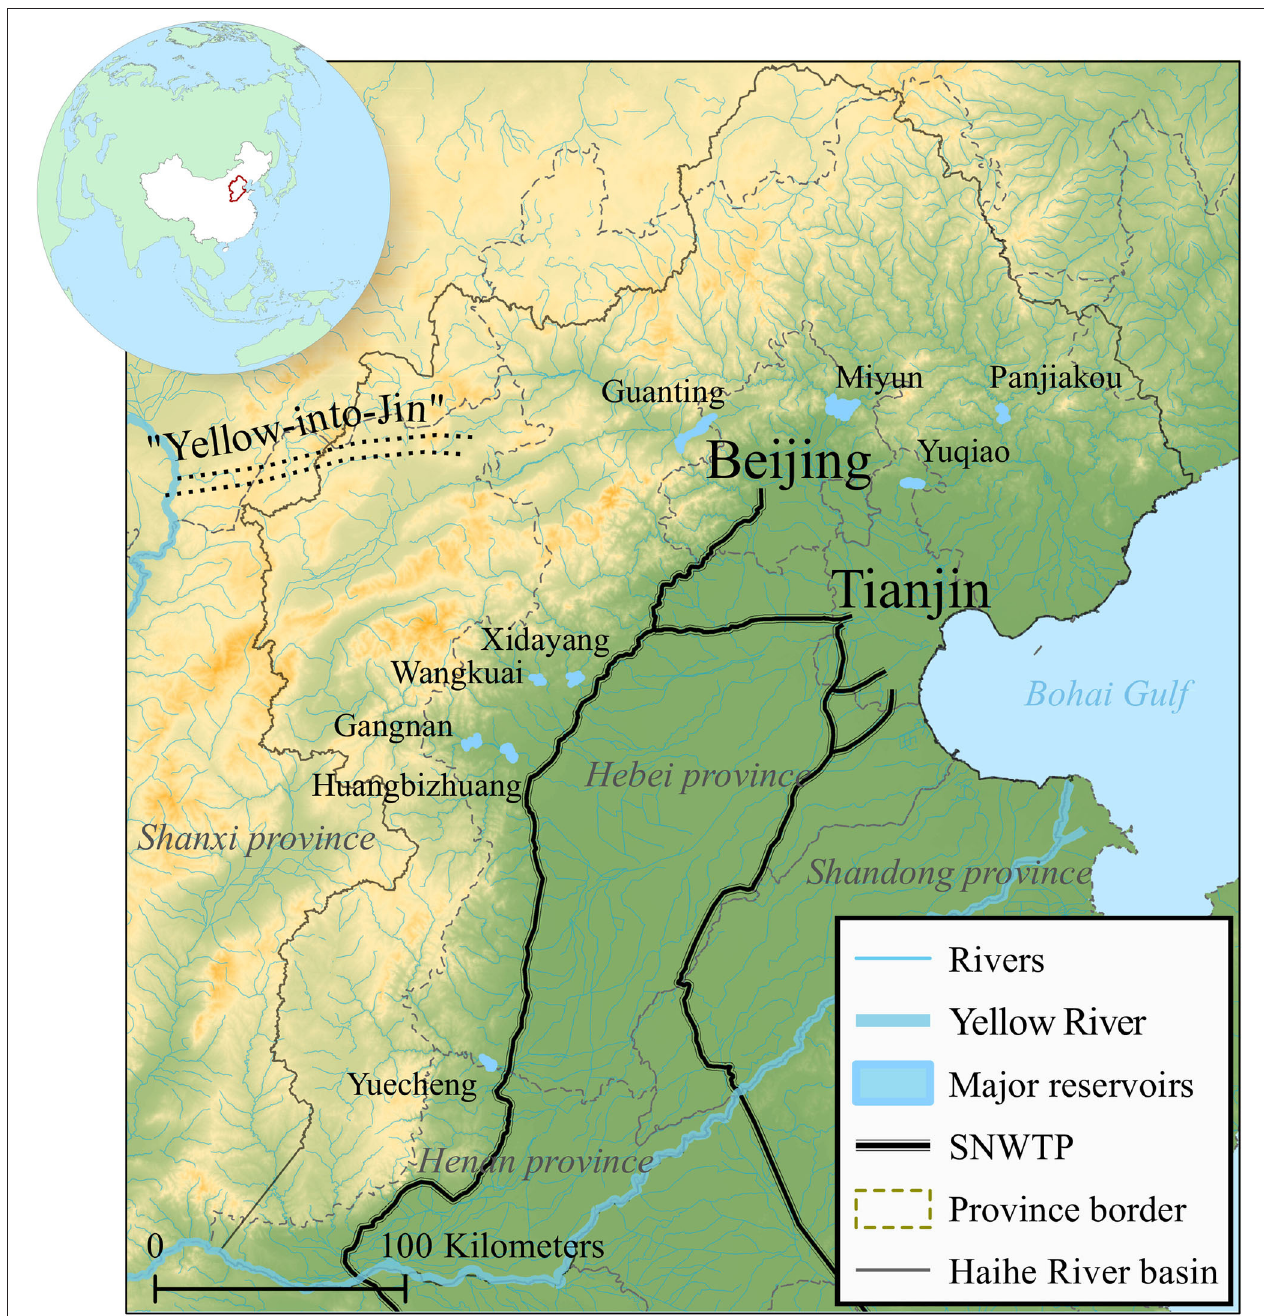
FIGURE 1 | Map of the Hai River basin, the nine major surface water reservoirs and the inter-basin transfers from the Yellow River “Yellow-into-Jin” and the South to North Water Transfer Project (SNWTP). Modified from Martinsen (2019).